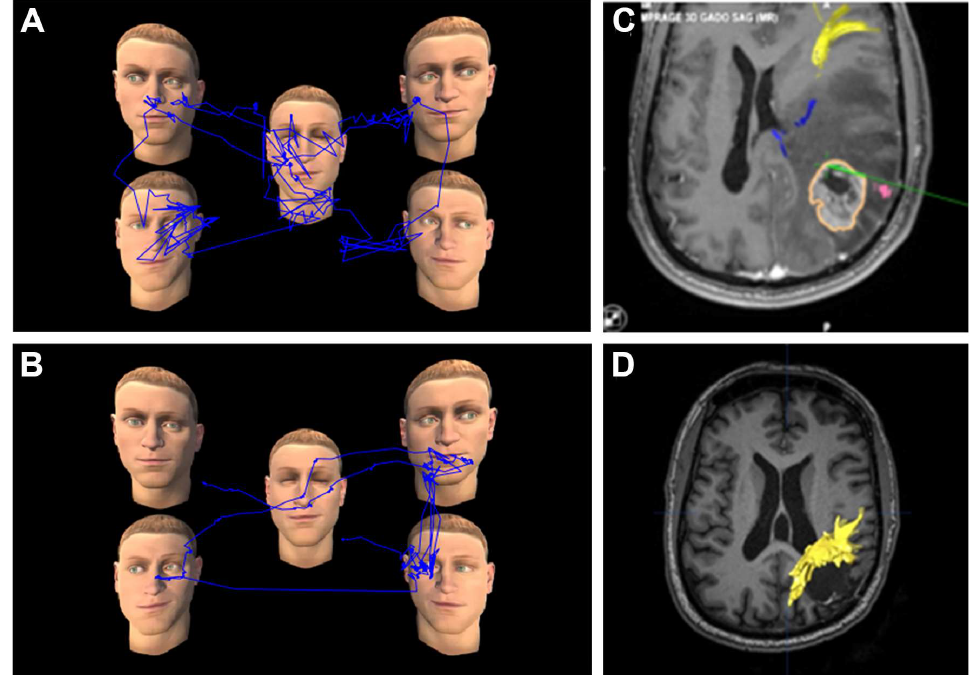
Figure 4. Resection of a malignant glioma located in the right temporo-parietal junction. ( A ) In- traoperative test without DES, with a normal performance. Gaze exploration, materialized by the blue line, indicated that the patient was able to explore the entire VRH screen and to find the avatar making eye contact (here, in the lower left corner). ( B ) Intraoperative test during DES of the white matter on the resection cavity wall, with an impaired performance. The patient had difficulties ex- ploring the left part of the screen and was not able to find the avatar making eye contact (here, in the upper left corner). ( C ) Neuronavigation view showing the location of the DES electrode in con- tact with the SLF, not entirely visualized due to the peritumoral edema. ( D ) Postoperative tractog- raphy confirming the location of the electrode in contact with the SLF. (DES, direct electrical stimu- lation; SLF, superior longitudinal fasciculus) Figure 5. Resection of a malignant glioma in the frontal lobe. ( A ) VR-TANGO test during the DES. The patient was unable to detect the communicative cues, namely, eye contact (green square at the